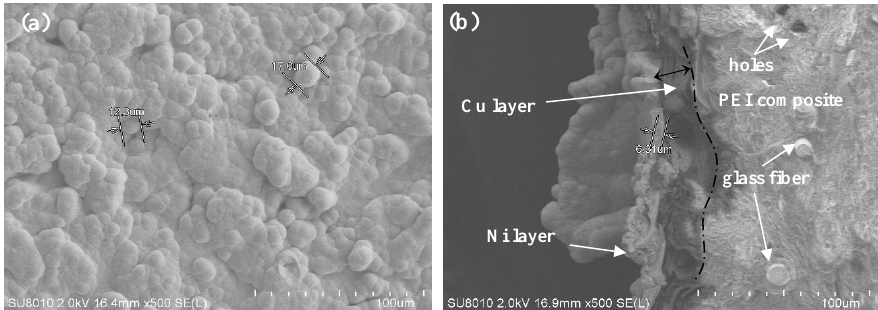
Figure 7. SEM images of top-surface ( a ) and fracture ( b ) of multilayer deposit on PEI substrate after sandblasting